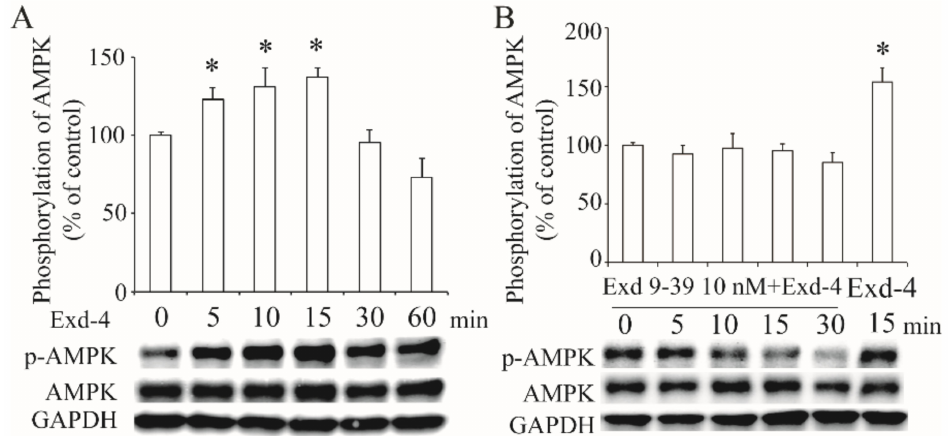
Figure 4. Activation of AMPK signaling by exendin-4 via GLP-1 receptor . The phosphoryla- tion of the AMPK α subunit at Thr172 in HUVECs treated with exendin-4 ( A ), or together with exendin9-39 ( B ). The ratio of p-AMPK to AMPK is shown as percent of control. A graph showing the mean ± SEM (n = 3) of separate experiments for each treatment group is included. * p < 0.05 compared with control.